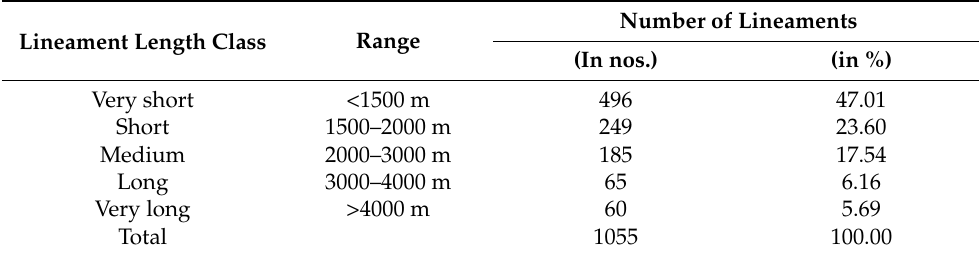
Table 3. Lineament length class of automatically extracted